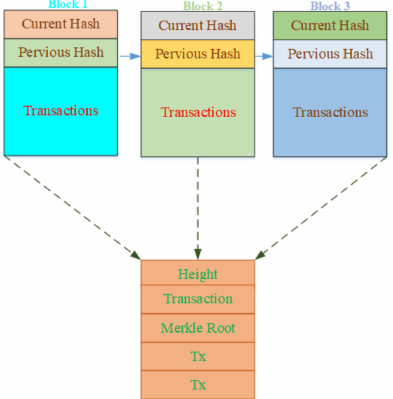
Figure 3. A block construction in blockchain.